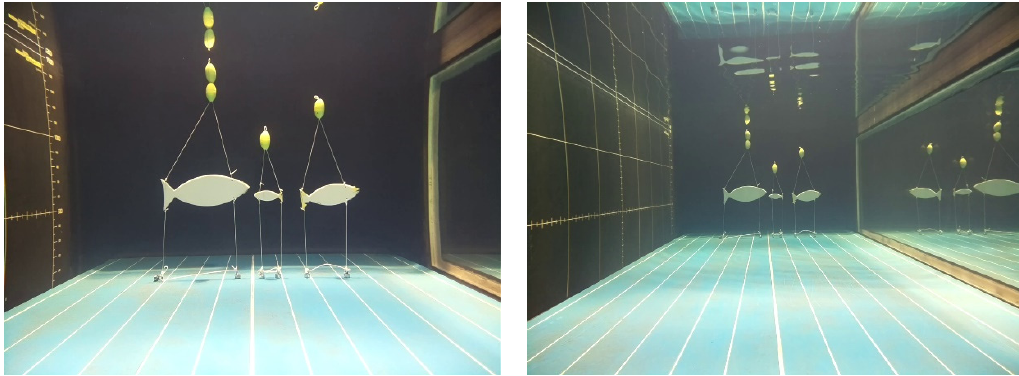
Figure 13. Images of fish silhouettes taken in the Ifremer pool taken with the KOSMOS camera at distances of 3 m ( left ) and 6 m ( right ).